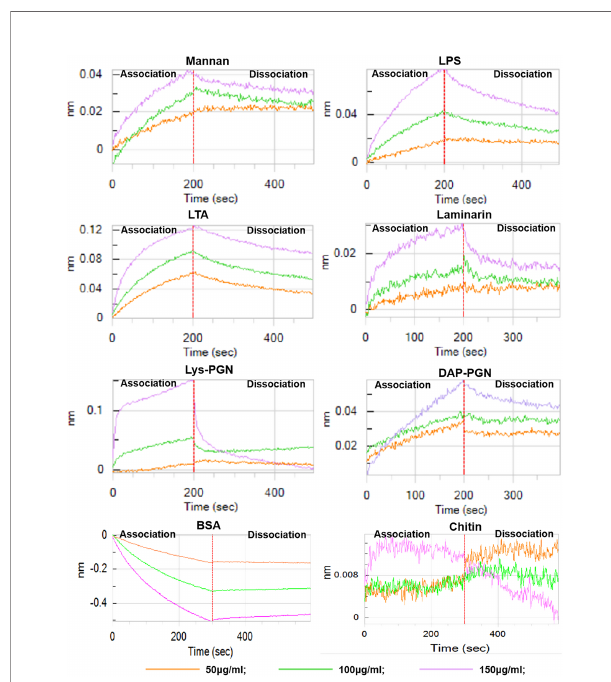
FIGURE 3 | Binding of His 6 - Ap -hemolin to soluble PAMPs. A biolayer interferometry binding assay was performed to detect the binding of His 6 - Ap - hemolin to six soluble microbe-derived PAMPs, including mannan, LPS, LTA, laminarin, Lys-PGN and DAP-PGN. The vertical and horizontal axes represent the light shift distance (nm) and association/dissociation time (s), respectively. As negative controls, the binding of His 6 - Ap -hemolin to chitin (C9752) and bovine serum albumin (V900933) purchased from Sigma – Aldrich (Poole, USA) was also